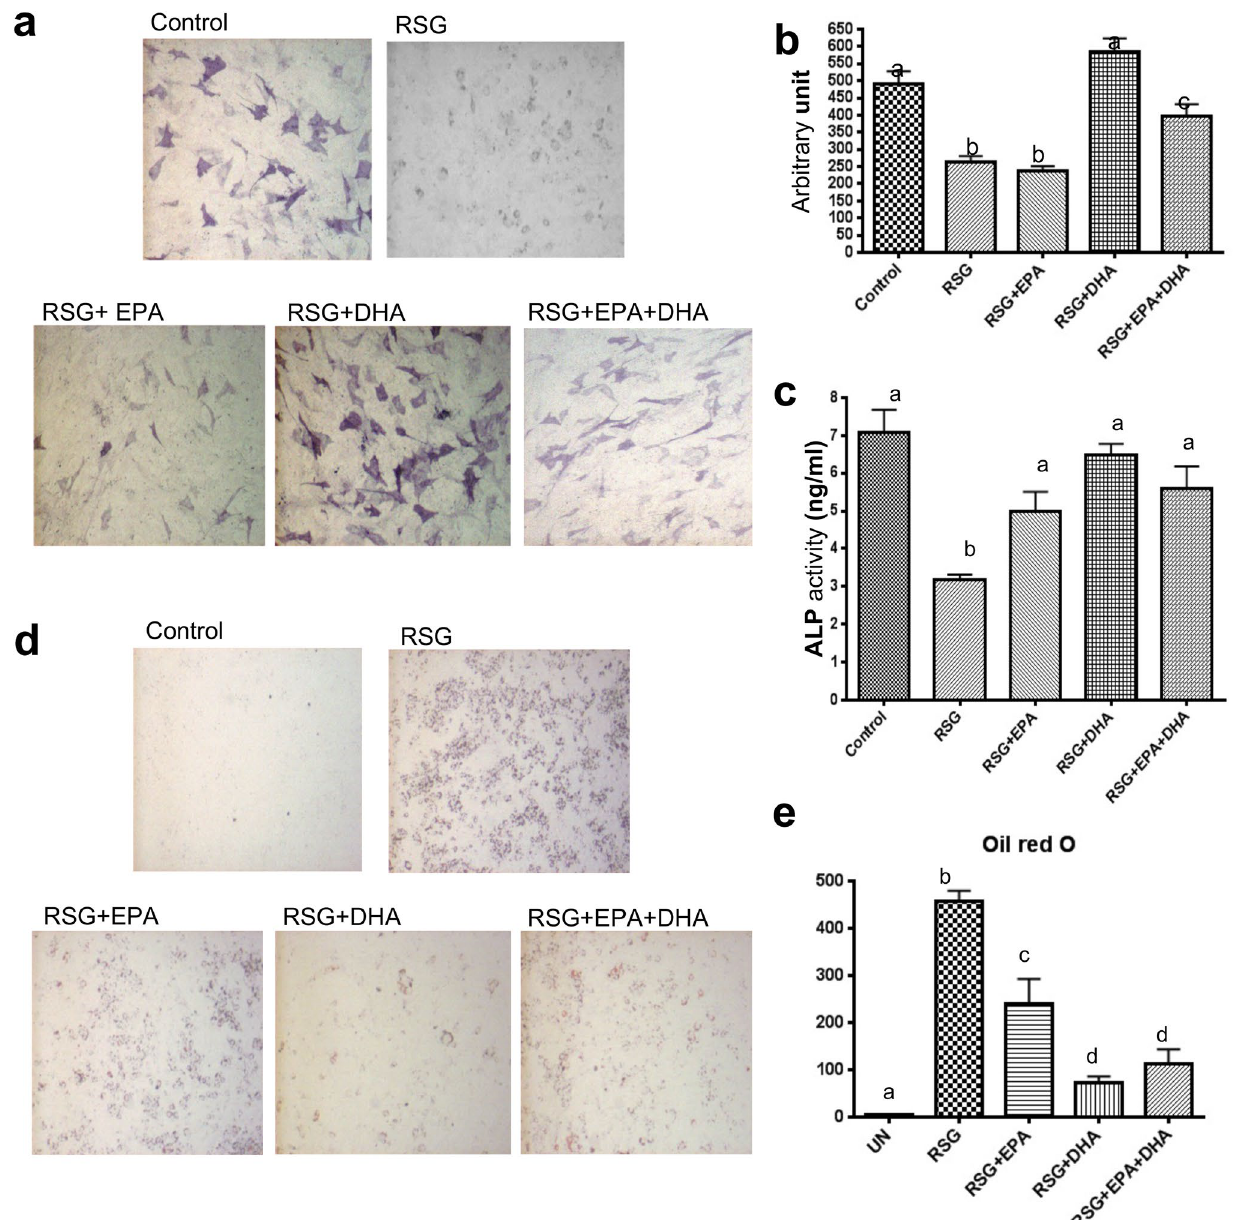
Figure 1. Effect of RSG with or without omega-3 FAs on osteoblastogenesis and adipogenesis in C3H10T1/2 cells. C3H10T1/2 cells were plated in a 48-well plate and cultured in α-MEM medium with 10% FBS supplemented with recombinant human (rh) BMP-2 (Biovision, USA) and cultured for 7 days in the presence of RSG 1 µM with or without EPA 10 µM and/or DHA 10 µM. Representative photographs (20×) of C3H10T1/2 cells stained for alkaline phosphatase (elongated cells) ( a ). Optical density measured by Metaview Image Analysis (Olympus Inc. USA) in RSG treated cells with and without FO (EPA and DHA) in the presence of BMP-2 ( b ). Cells were lysed with lysis buffer and quantified for protein content. Alkaline phosphatase (ALP) activity was measured by using SensoLyte pNPP ALP Assay by mixing cell lysates with pNPP reaction mixture and incubated for 30 min. ALP activity in each sample was determined by measuring OD405 and compared to an ALP standard curve ( c ). Cells were then stained with Oil red O using fast red AL salt as a substrate. Representative photographs (20x) of C3H10T1/2 cells stained for Oil red O (round cells) ( d ). Optical density measured by Metaview Image Analysis (Olympus Inc. USA) in RSG-treated cells with and without FO (EPA and DHA) supplementation ( e ). Each bar represents the mean ± SEM of 6 wells per group. Value with different superscripts is significantly different at p < 0.05 by Newman–Keuls’ one-way ANOVA with multiple comparison tests. ALP Alkaline phosphatase, RSG rosiglitazone, EPA eicosapentaenoic acid, DHA docosahexaenoic acid, MEM minimum essential medium, BMP‑2 bone morphogenetic protein